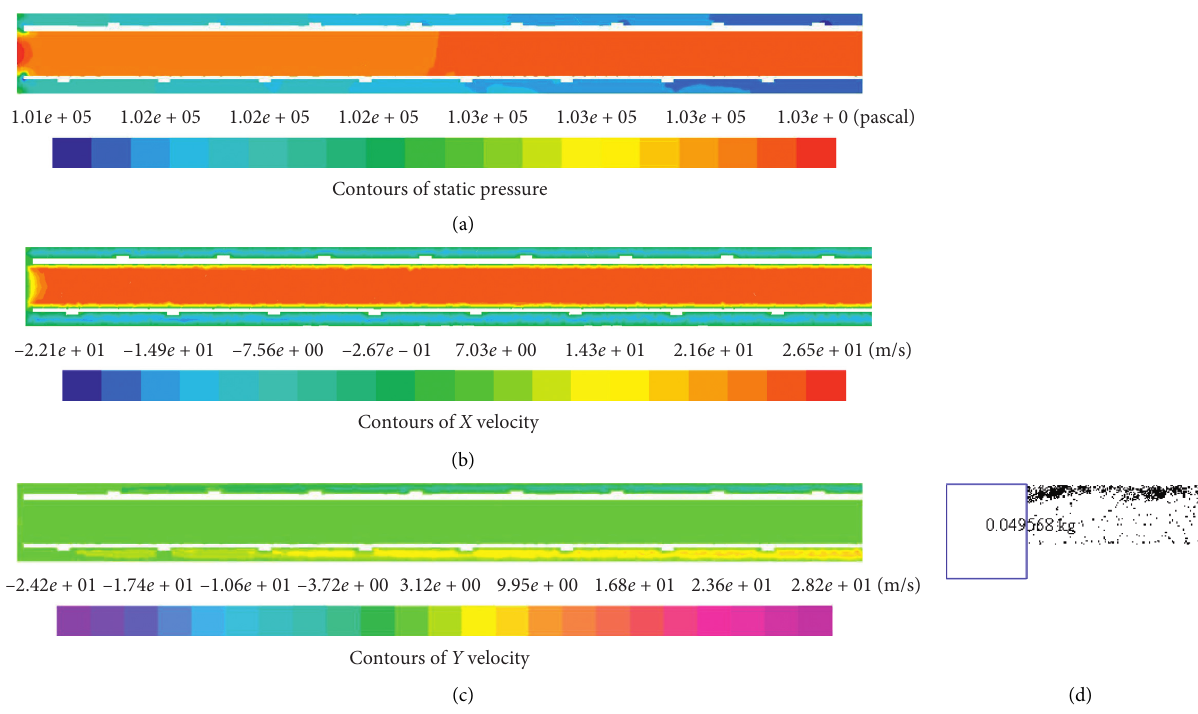
Figure 8: Simulation results of optimized drill pipe. (a) Nephogram of static pressure distribution for airflow migration. (b) Distribution nephogram of X direction velocity of flow. (c) Distribution nephogram of Y direction velocity of flow. (d) Mass of discharge